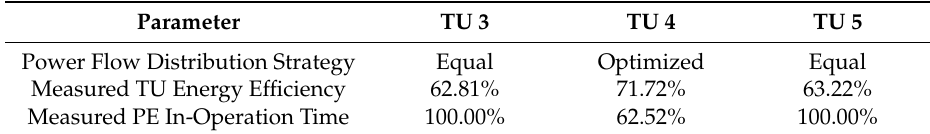
Table 5. Field-test results for Technical Unit (TU) energy efficiency and in-operation time of Power Electronics (PE) with equal Power Flow Distribution Strategy (PFDS) (TU 3, TU 5) and optimized PFDS (TU 4). Data for energy efficiency are for 3–14 August 2017. Data for PE in-operation time are